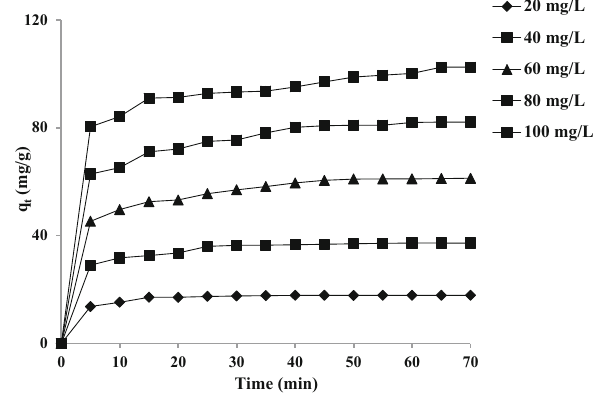
Fig. 7 Effect of pH on the removal of MB onto C-ZMN. Initial MB concentration: 100 mg L - 1 ; adsorbent amount: 0.8 g L - 1 ; agitation time: 70 min; temperature: 298